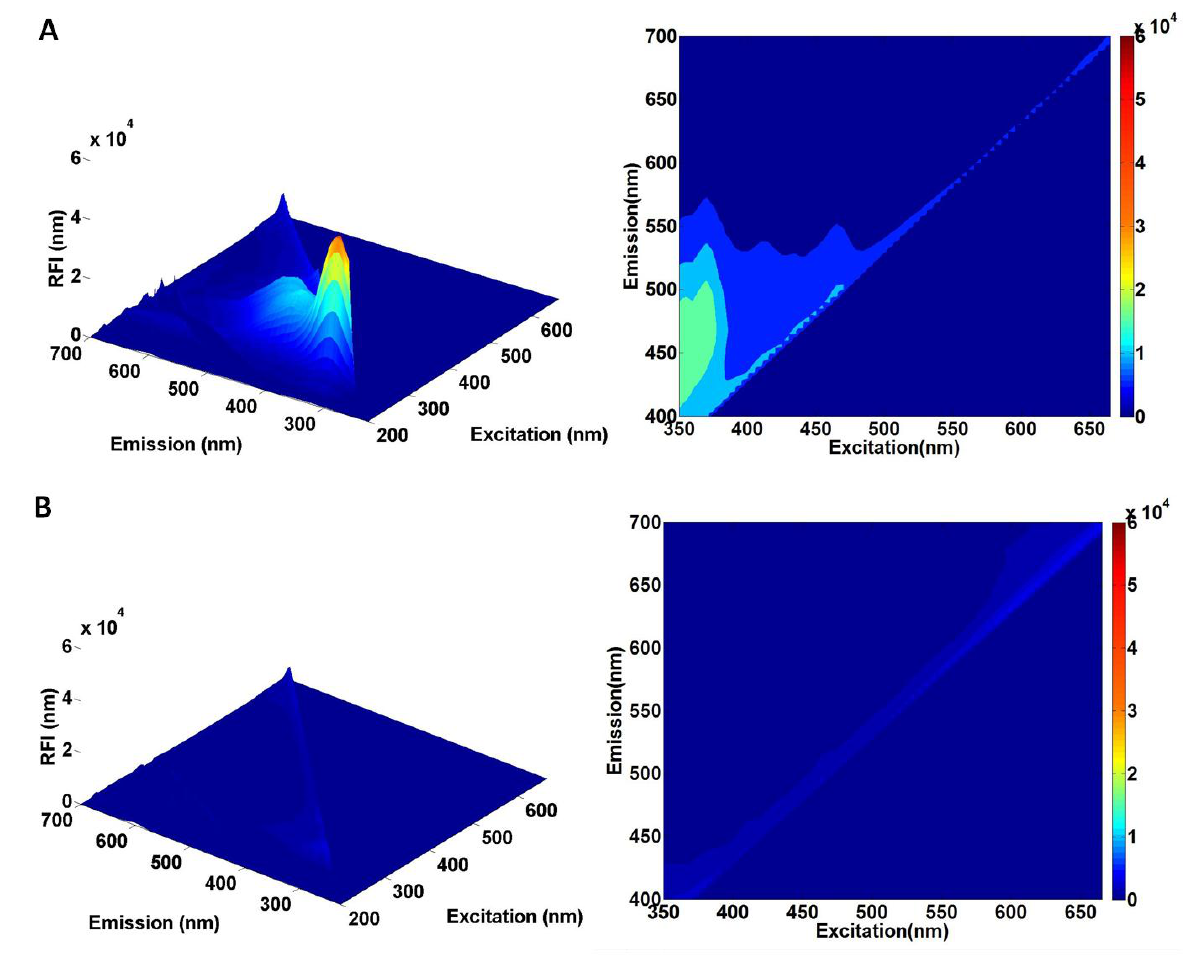
Figure 3. Averaged EEM of each data set of ( A ) crack; ( B ) sound skin; ( C ) stem with the spectral rage of excitation from 200 to 655 nm and emission from 225 to 700